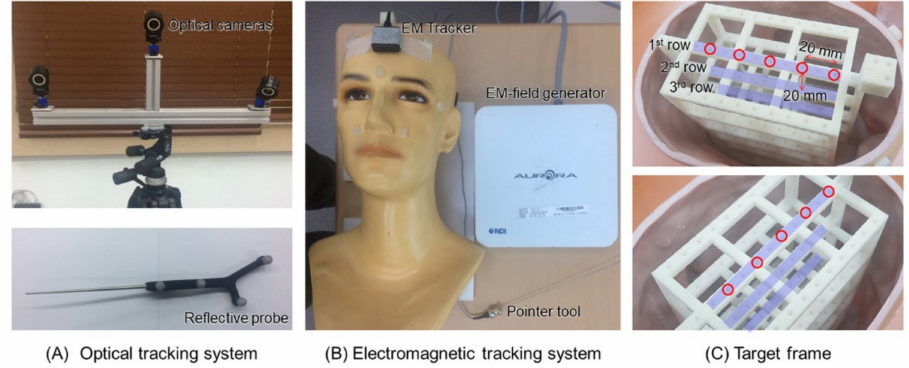
Figure 6. Apparatus and experimental setup ( A – C